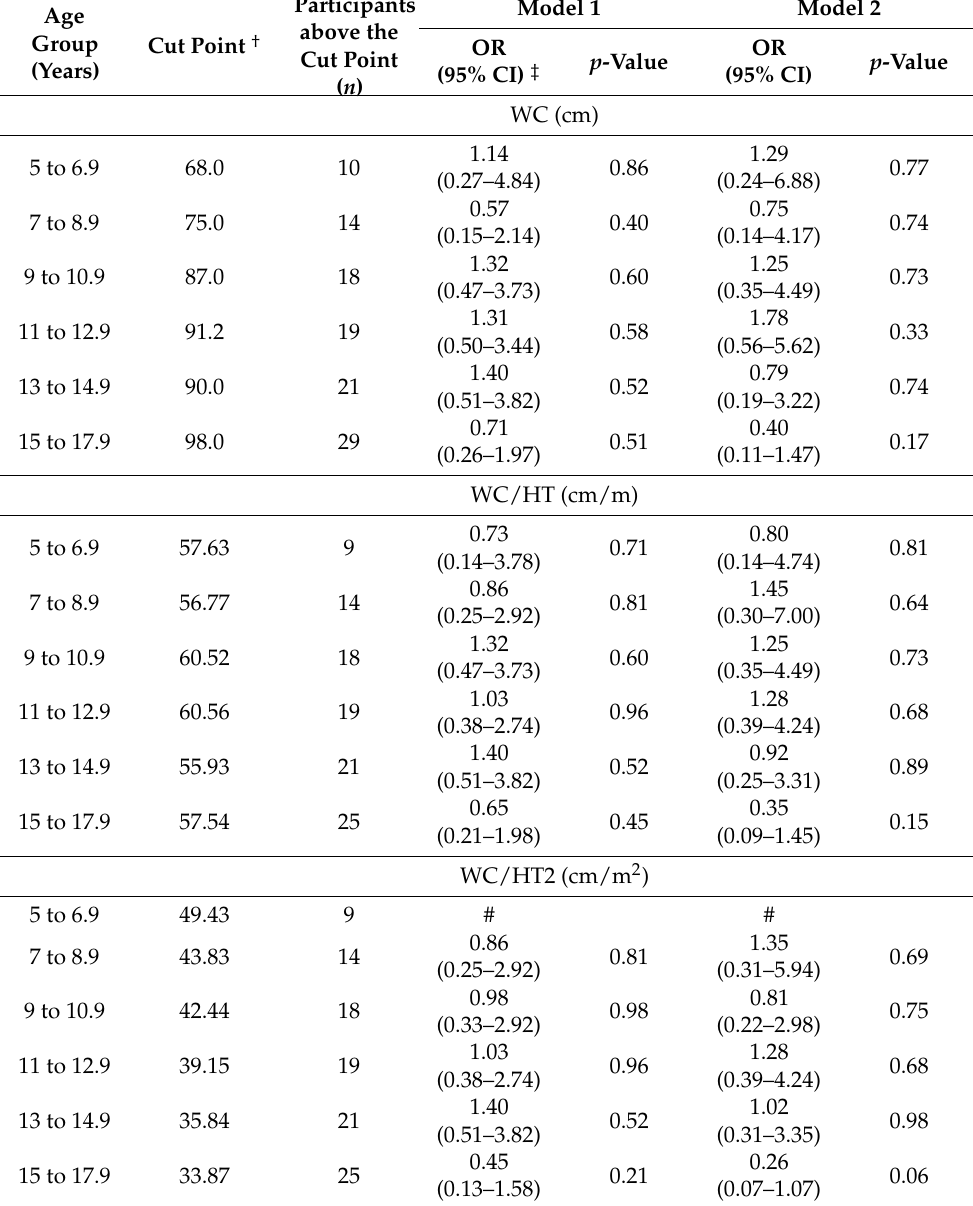
Table 4. Association between having a high ( ≥ 90th percentile) waist circumference (WC), waist circumference corrected for height (WC/HT), or waist circumference corrected for height